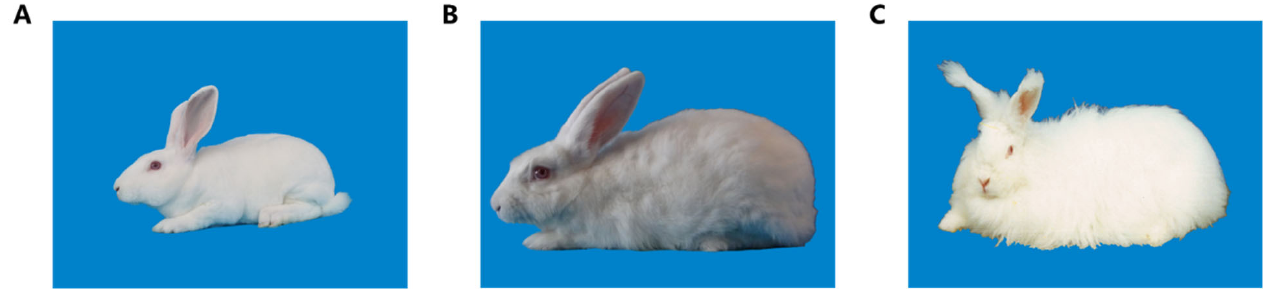
Figure 1. Different fiber length traits of three rabbit breeds. ( A ) Rex rabbit. ( B ) New Zealand rabbit. ( C ) Angora rabbit.